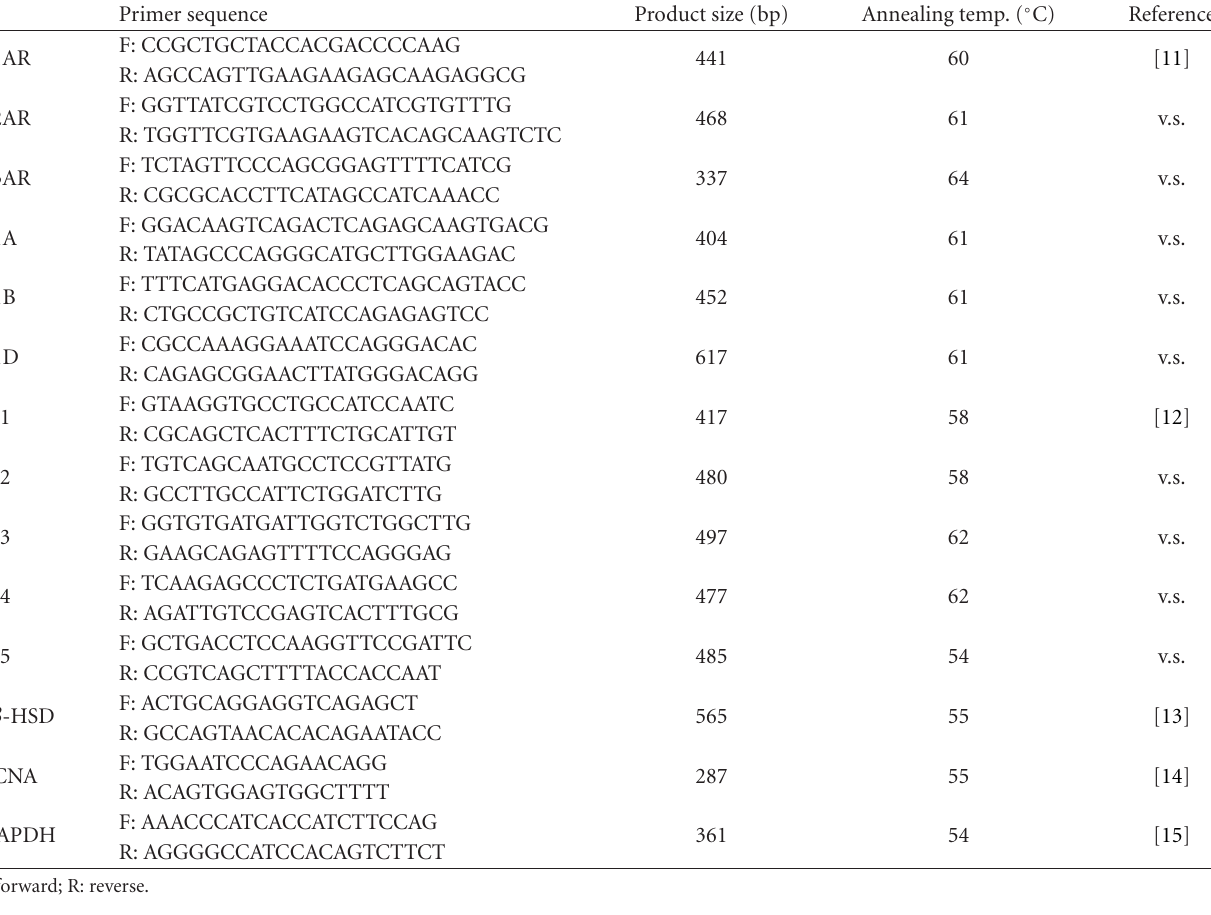
Table 1: Primer sequences.